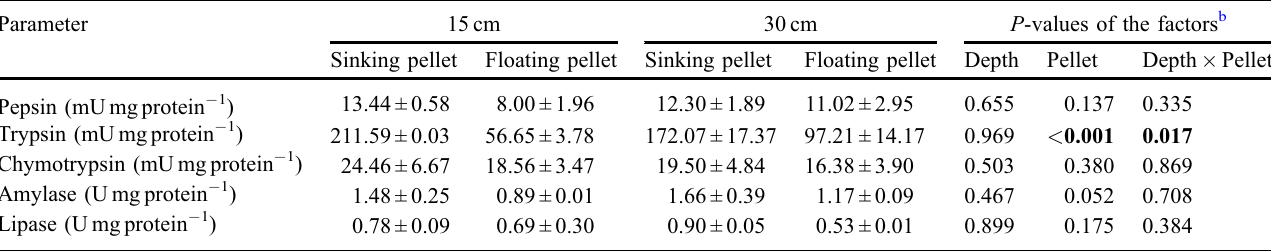
Table 3. Speci fi c activities of fecal digestive enzymes in post-hatching green turtles when reared under different water depths (15 and 30cm) and fed with commercial feed pellets (sinking or fl oating type). a The data (mean±SEM) are for turtles sampled at the end of the experiment.